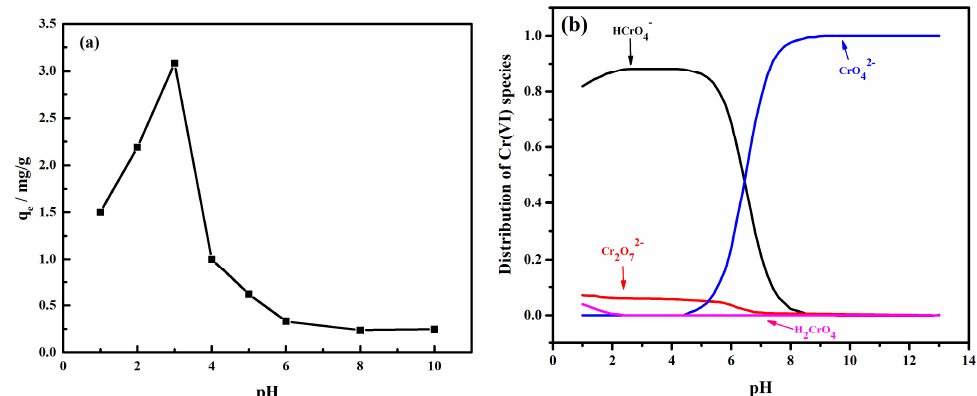
Figure 2. The Cr(VI) removal ( a ) and species ( b ) at various pH values.